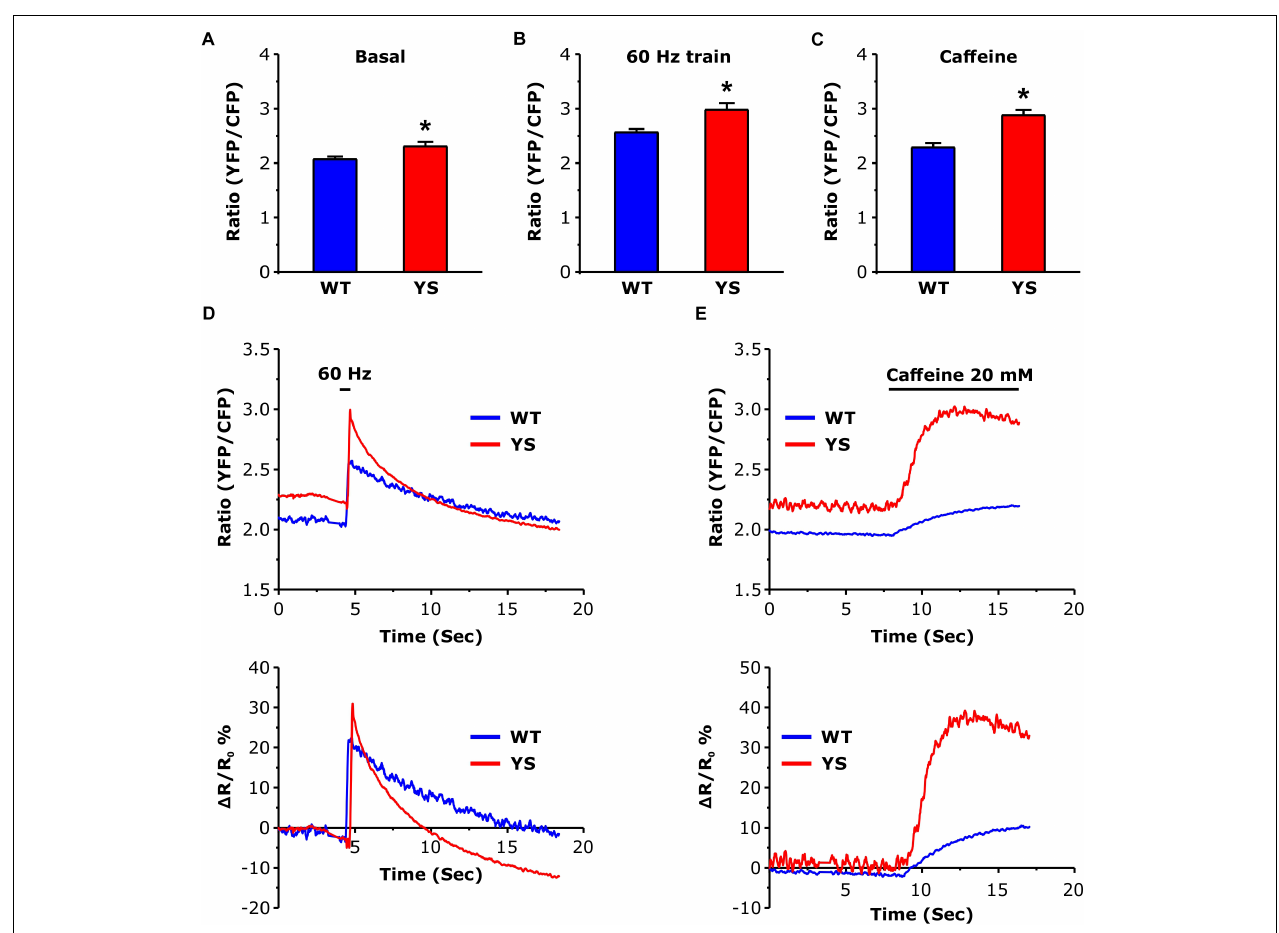
FIGURE 3 | Free Ca 2 + concentration in the mitochondrial matrix as determined by YFP/CFP ratio of 4mtD3cpv cameleon. (A) Basal resting Ca 2 + levels in the mitochondrial matrix. (B) Peak of Ca 2 + level in the mitochondrial matrix reached at the end of a train of electrical stimulation at 60 Hz, 2 s duration. (C) Peak of Ca 2 + level in the mitochondrial matrix following exposure to 20 mM caffeine. (D) Representative traces of variations of YFP/CFP ratio of 4mtD3cpv cameleon signal before, during, and after a 2 s electrical stimulation at 60 Hz (horizontal line). (E) Representative recordings of initial variations of 4mtD3cpv cameleon signal before and after the administration of 20 mM caffeine (horizontal line indicates the time of the caffeine administration). Data are shown as means ± SEM; ∗ p < 0.05. Panels A and B : n = 20 WT and 30 YS fibers; panel C : n = 7 WT and 7 YS fibers.